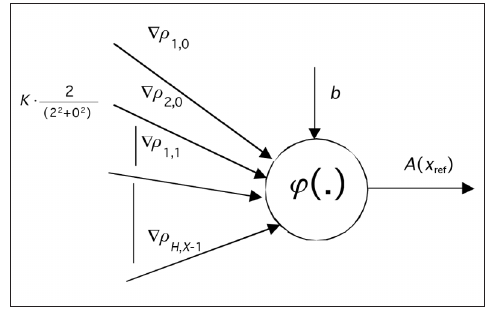
Fig. 2. Forced Neural Network (FNN) design for gravity